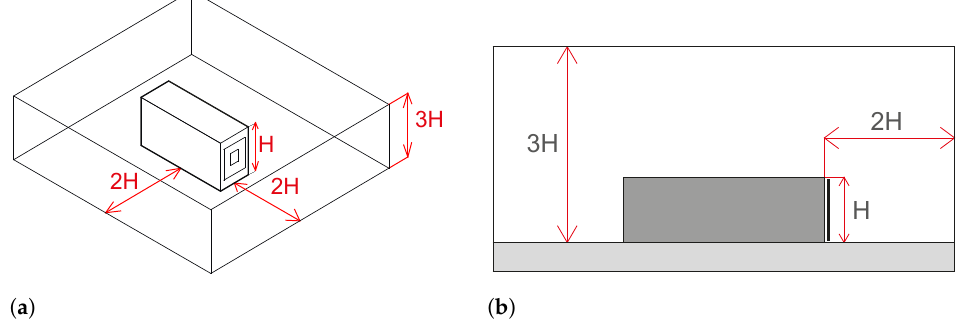
Figure 6. Non-scaled sketch of the computational domain: ( a ) 3D view; ( b ) longitudinal